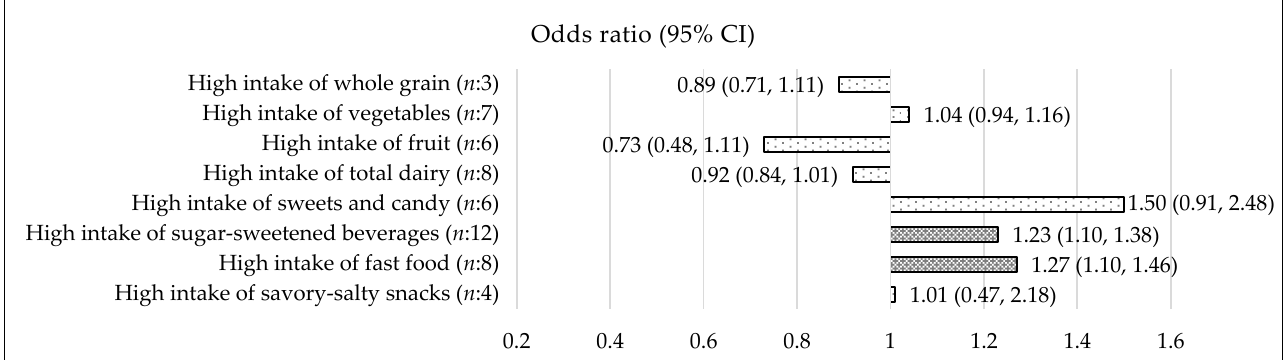
Figure 3. Association between a high intake of eight different food and beverages categories and risk of overweight/obesity in children 5–11 years. OR < 1 = decreased risk of overweight/obesity, OR > 1 = increased risk of overweight/obesity. Dark shades are significant ( p ≤ 0.05). White shades are not significant. The forest-plots for each food or beverages category is available in Supplementary Figures S16–S24.